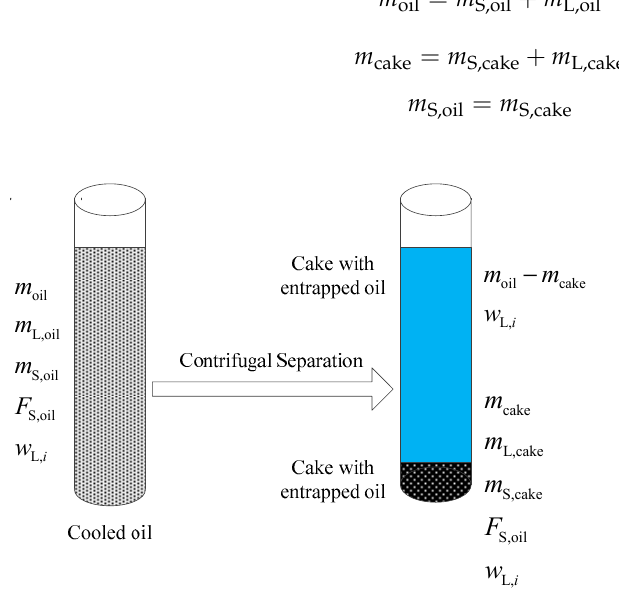
Figure 2. Analysis of the centrifugation process.